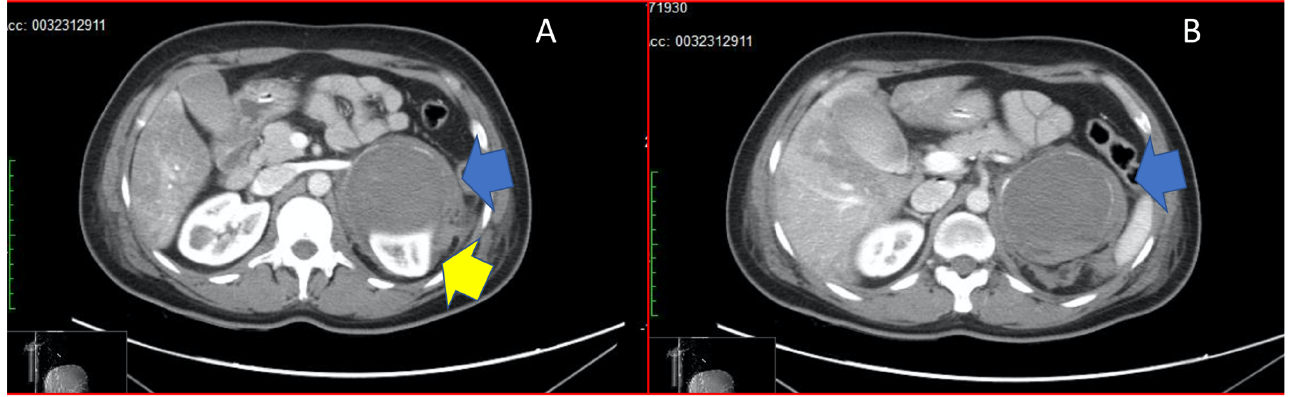
Figure 1. Panel ( A ) shows adrenal mass (blue arrow) compressing the upper pole of the left kidney (yellow arrow). Panel ( B ) shows the adrenal mass in its total size, with haemorrhagic infarction (blue arrow).